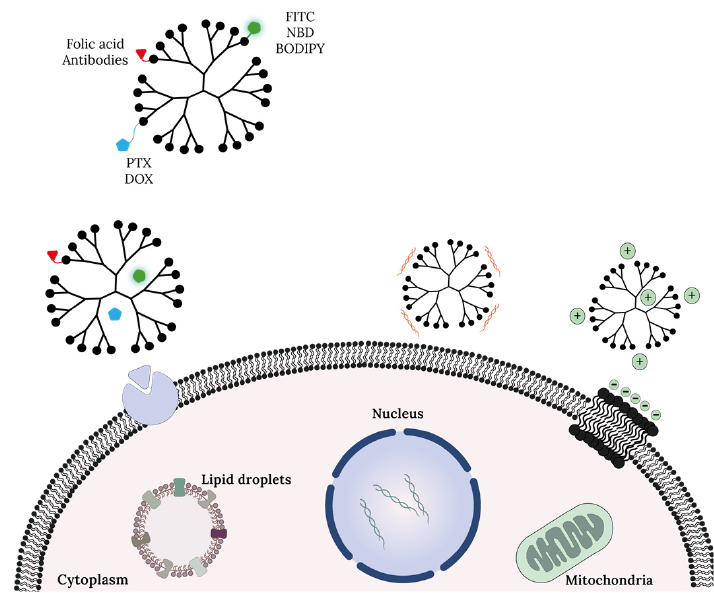
Figure 5. Schematic representation of potential intracellular cellular organelles (including plasma membrane, lipid droplets, cell nucleus, and mitochondria) targeted by dendrimers used in anticancer strategies. Cationic surface of cationic modified dendrimers is known to strongly interact with negatively charged lipids present in cancer cell membranes. Cationic dendrimers are also shown to specifically target mitochondria.